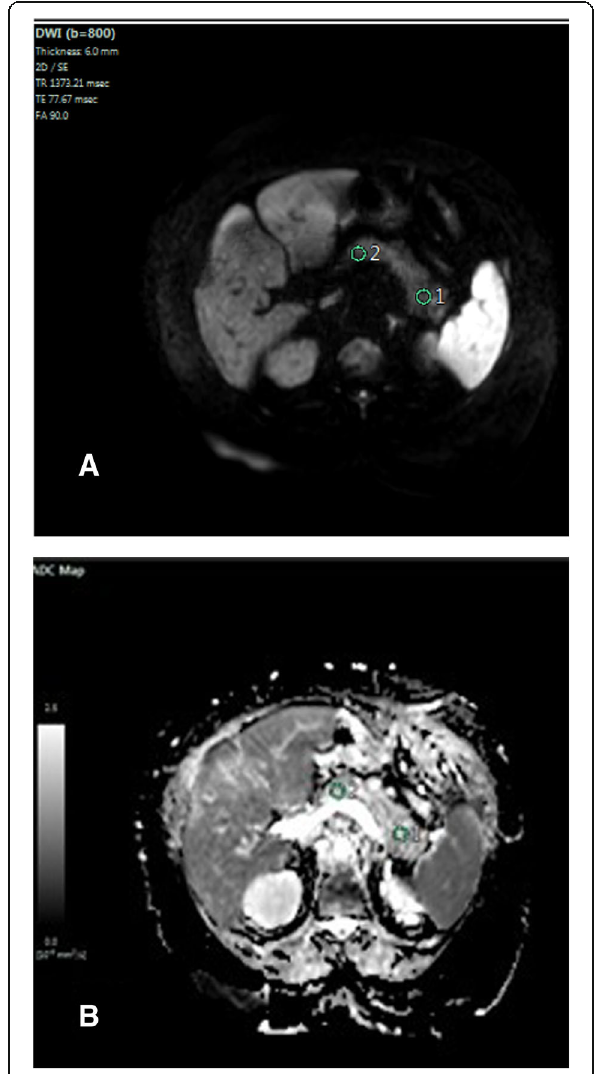
Fig. 3 DWI showing no restriction of pancreatic parenchyma and high ADC value of pancreas on ADC